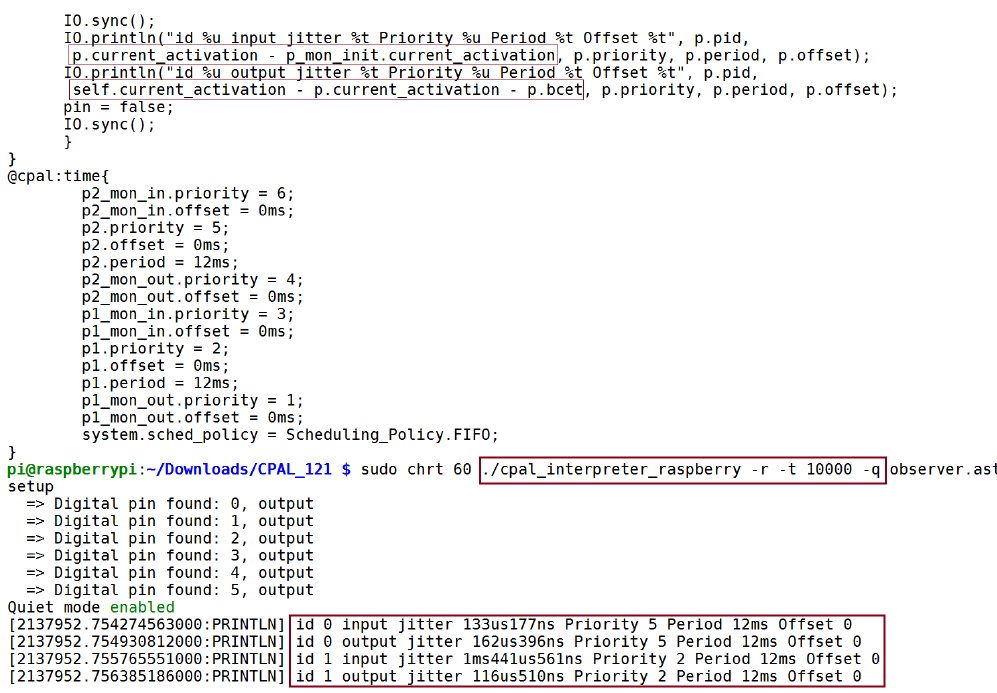
Figure 10. Code snippet of the two monitoring processes, including their scheduling